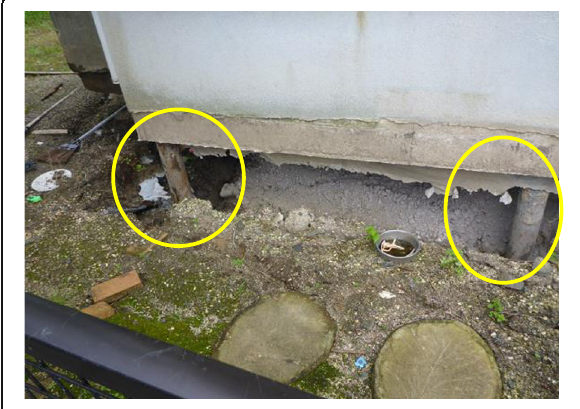
Fig. 12 The pile foundation of the house which experienced minor inclination in